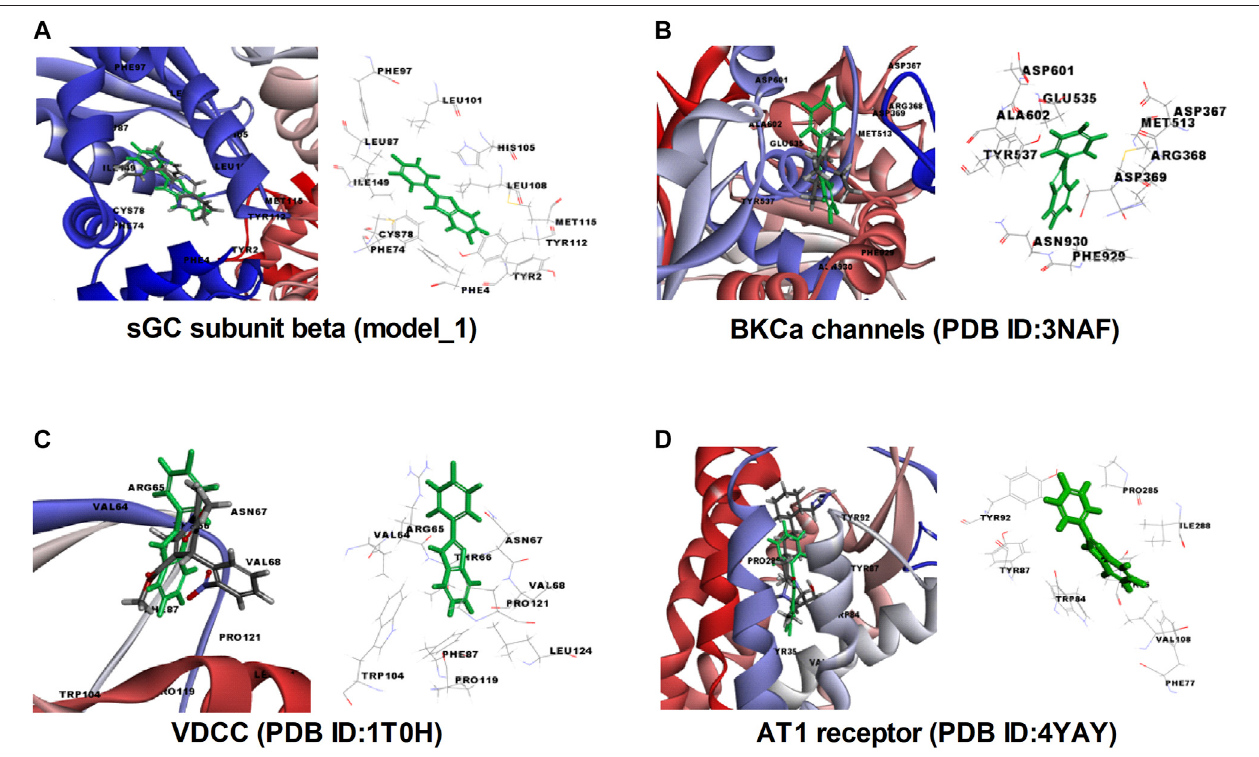
FIGURE 10 | Molecular insight, interactive amino acid residues, and binding site conformation of FPD (green) with control compound (element color) docked on sGC subunit β (homology model_1). (A) , BK Ca channels (PDB ID: 3NAF). (B) VDCC (PDB ID: 1T0H). (C) angiotensin II receptor 1 (PDB ID: 4YAY). (D) .